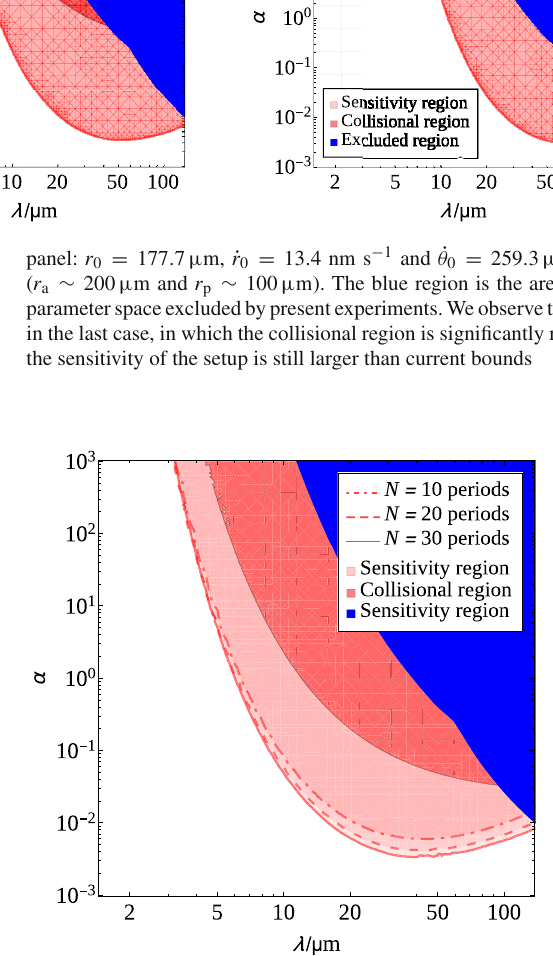
Fig. 8 Sensitivity of the proposed experimental setup in the ( λ,α ) plane at the 95% CL The blue region represents the present experi- mental bounds (see Fig. 3). The dark red-meshed region is the part of the parameter space for which a Beyond-Newtonian potential induces collision between S and P (whereas for a Newtonian potential S would orbit around P). Eventually, the pink-shaded region is the part of the parameter space for which we can detect precession in the presence of New Physics (and that can be thus excluded in the case no signal is observed). The boundary of the sensitivity region is drawn for values of λ and α for which we expect the maximal variation of the period,